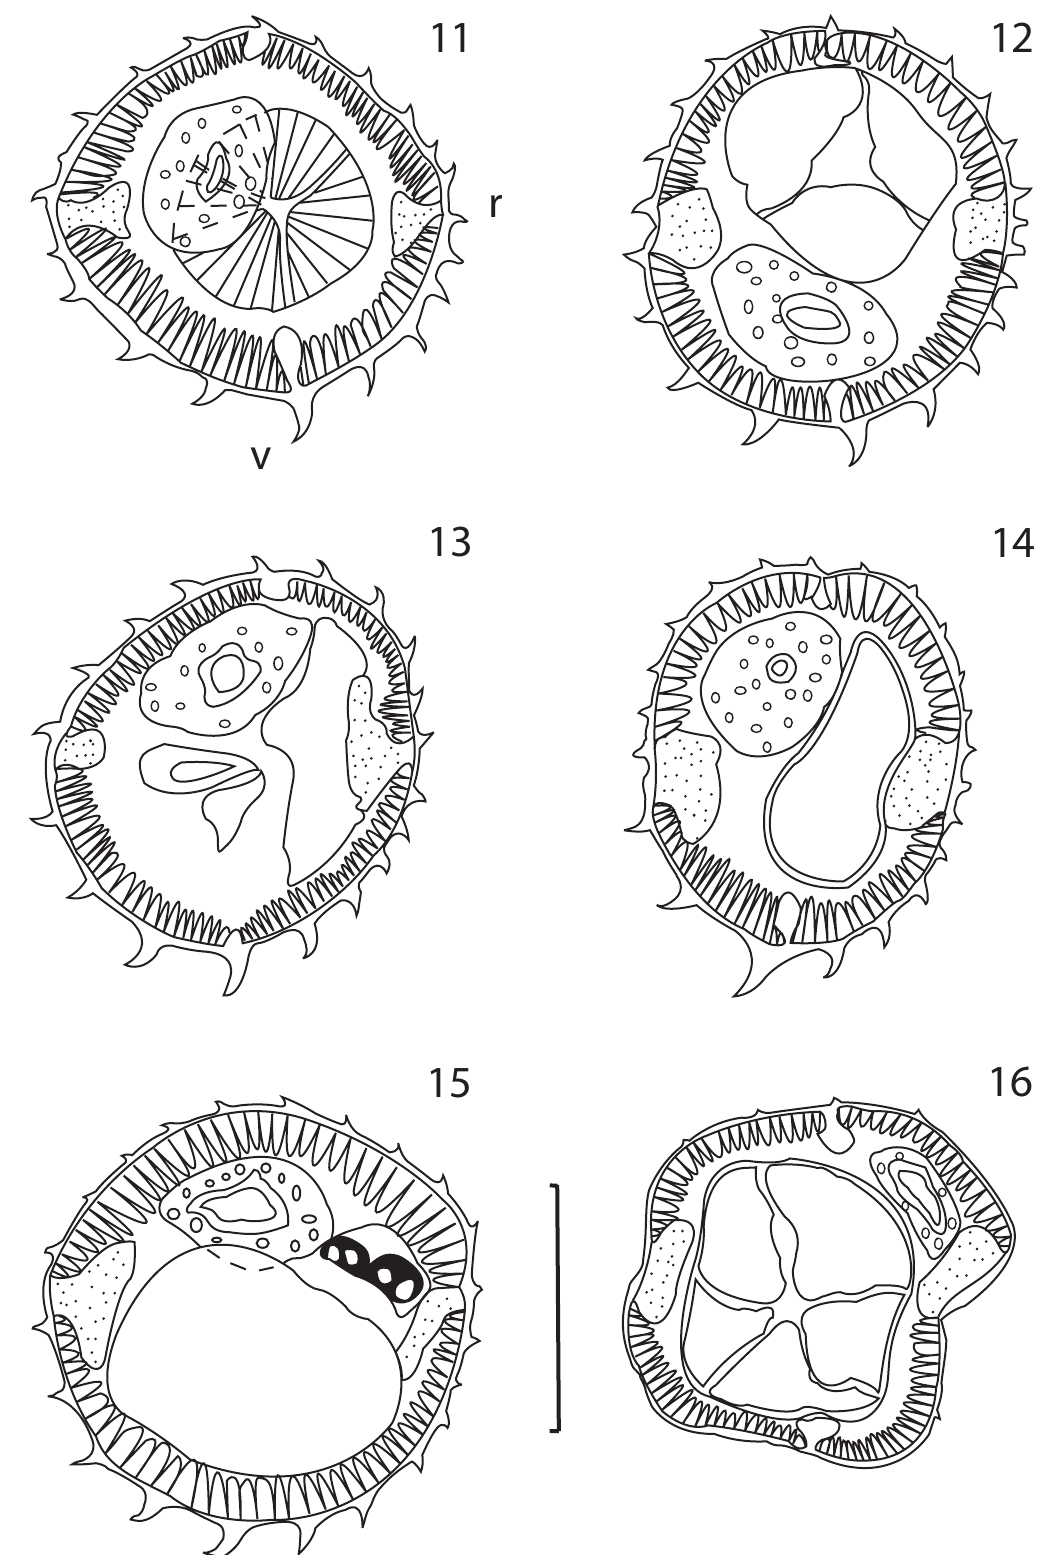
Figs 11-16. – Heligmosomoides craigi n. sp. in Microtus limnophilus , Transverse sections of body: 11, 12, at level of the oesophago-intes- tinal junction, 11, male, 12, female, 13, 14, at mid-body, 13, male, 14, female, 15 at about 1.2 mm anterior to caudal bursa, male; 16, at about 1 mm anterior to vulva, female. Scale bar: Figs 11-16: 50 µm. Abbreviations: r: right side, v: ventral side. Transverse sections orientated as